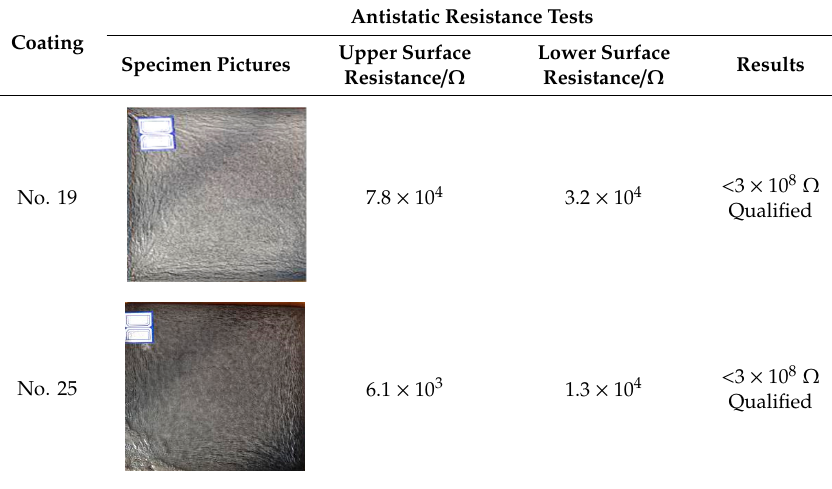
Table 4. Antistatic resistance properties of coating specimens No. 19 and 25.